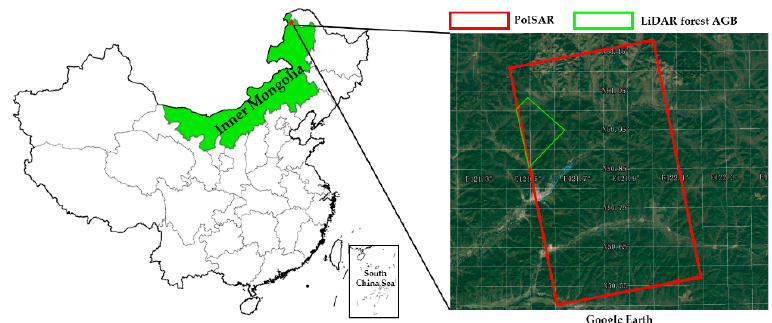
Figure 5 . Location of the test site and data coverage. Figure 5. Location of the test site and data